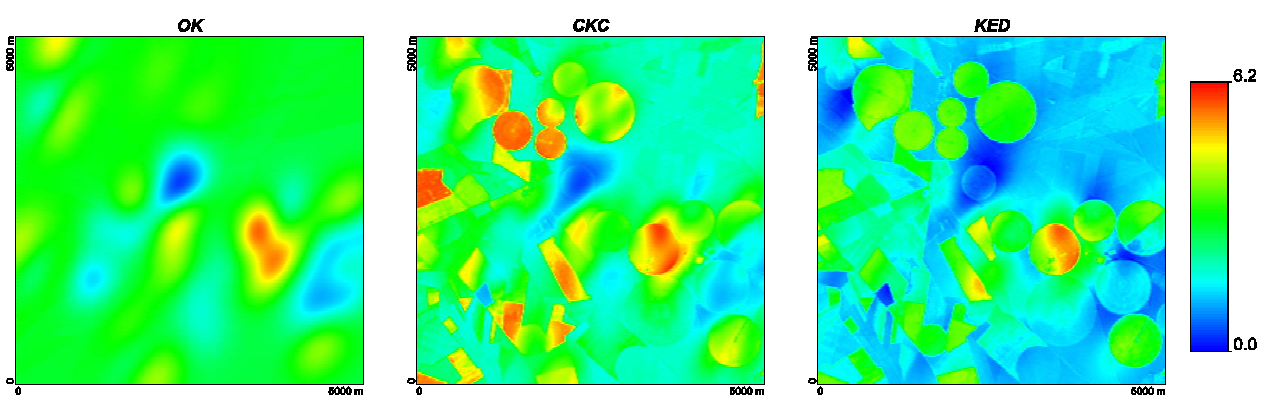
Figure 7. LAI fields from OK (left), CKC (center) and KED (right) models.